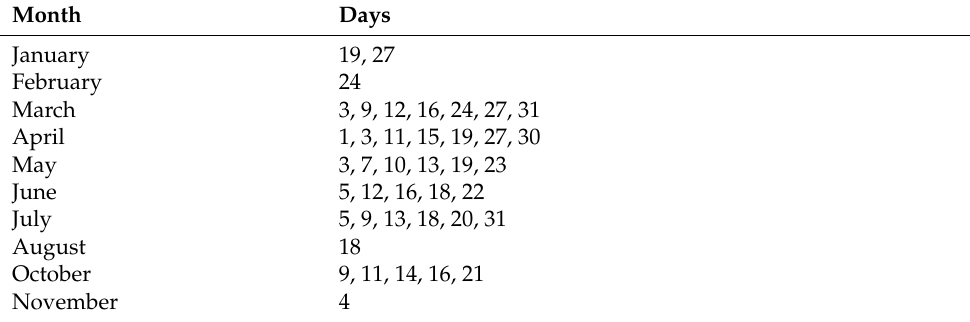
Table 3. Dates of widespread dust storm events covering different areas of Saudi Arabia on